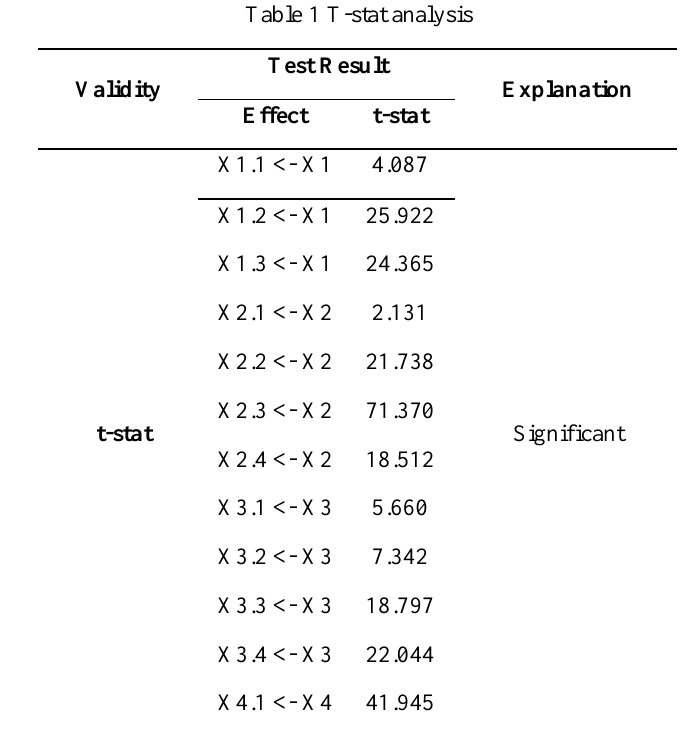
Figure 3 Inner Model